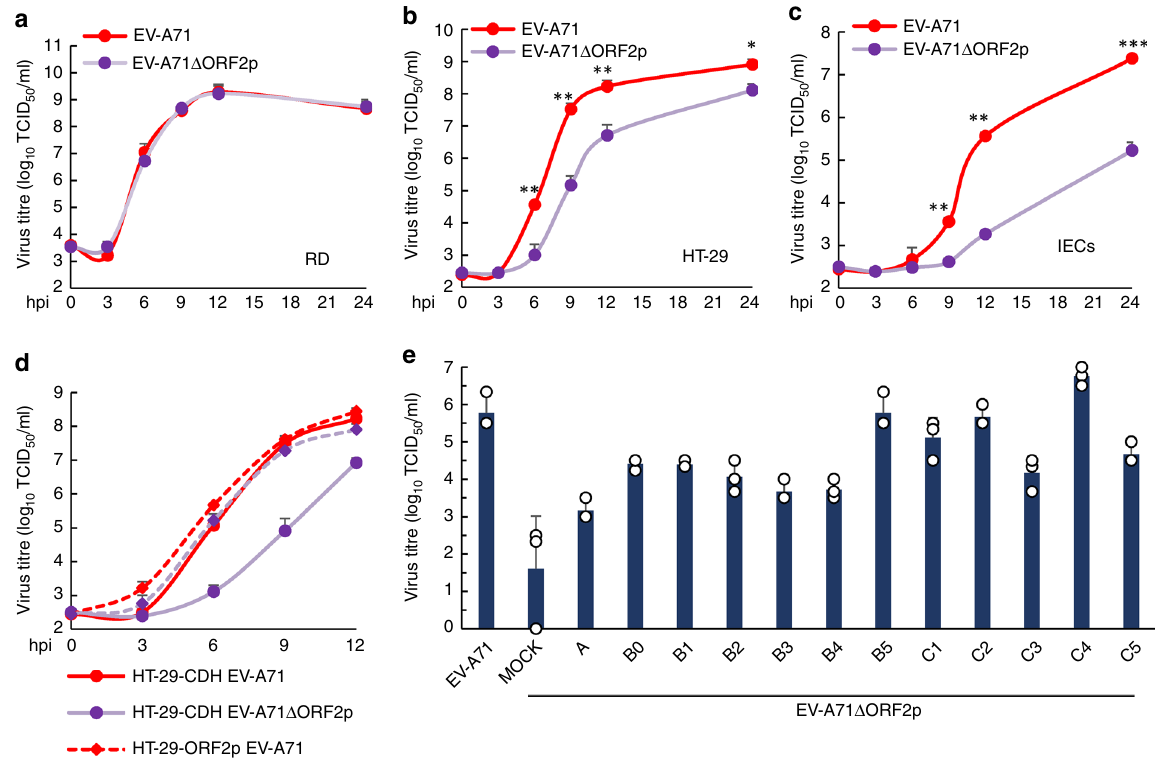
Fig. 2 ORF2p is crucial for intestinal infection by EV-A71. a – c One-step growth curve of EV-A71 and EV-A71 Δ ORF2p in RD, HT-29 and isolated primary IECs at an MOI of 10. Error bars denote SEM; ANOVA test, n = 3 biologically independent experiments; * p < 0.05, ** p < 0.01, *** p < 0.001. d HT-29 cells stably expressing EV-A71 ORF2p or control HT-29-CDH cells generated by transduction with the empty lentiviral vector pCDH-CMV-MCS-EF1-Puro were challenged with EV-A71 WT or EV-A71 Δ ORF2p at an MOI of 10. Viral titres were determined at 0, 3, 6, 9, and 12 hpi ( n = 3 biologically independent experiments). Error bars denote SEM. e HT-29 cells expressing the ORF2p protein derived from EV-A71 sub-genotypes A, B0, B1, B2, B3, B4, B5, C1, C2, C3, C4 and C5 were infected with EV-A71 Δ ORF2p at an MOI of 0.1. Viral titres were determined at 72 hpi ( n = 3 biologically independent experiments). Error bars denote SEM. Source data are provided as a Source Data fi